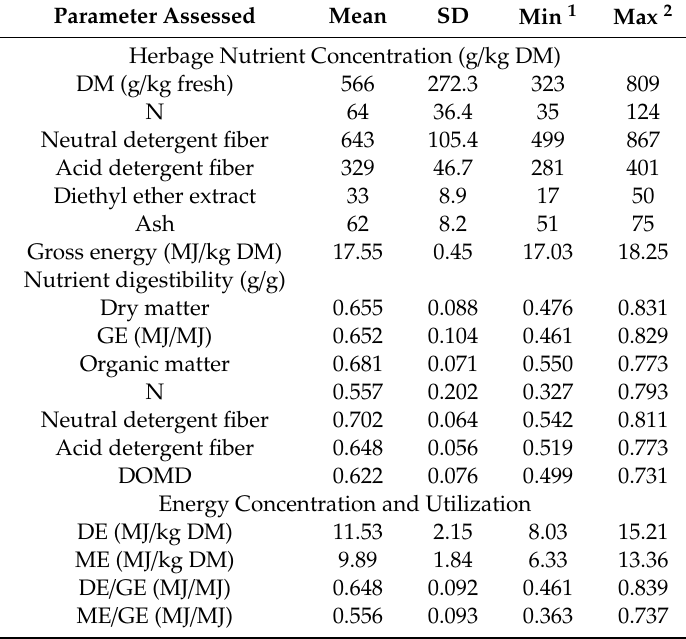
Table 1. Herbage nutrient concentration and digestibility and energy utilization data used in the present